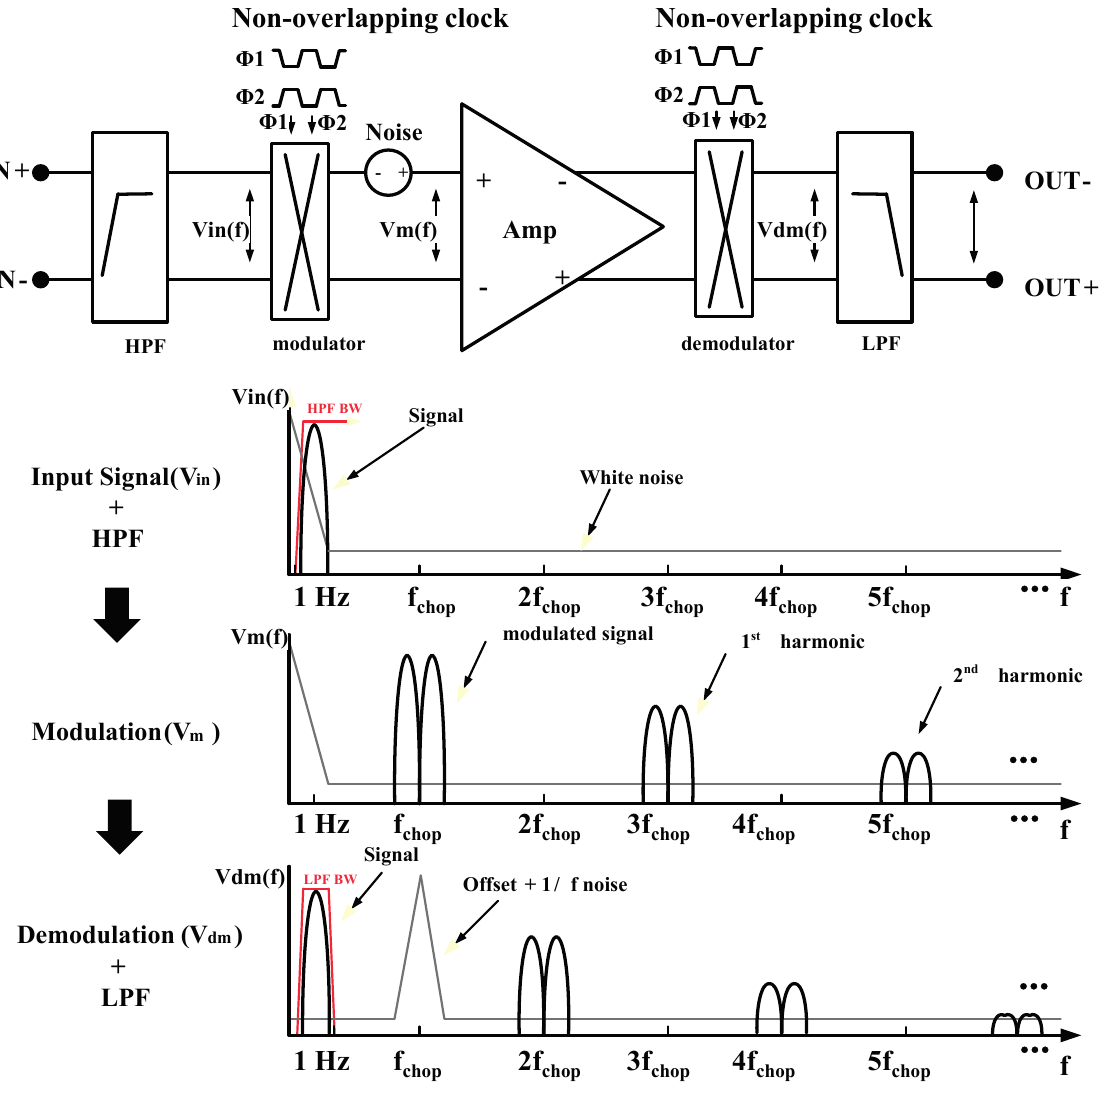
Figure 6. Principle of chopper stabilization.